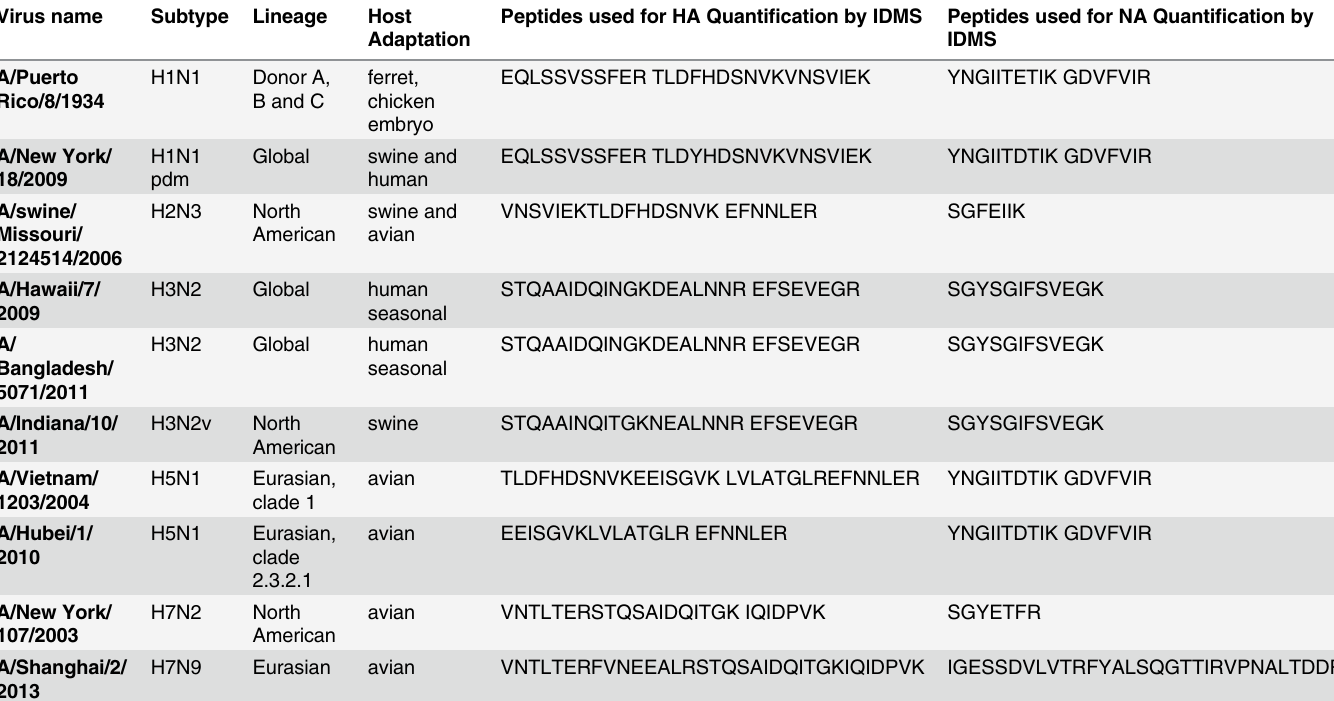
Table 2. HA and NA genes utilized in reassortment with selected PR8 donors along with IDMS peptides used in this study.